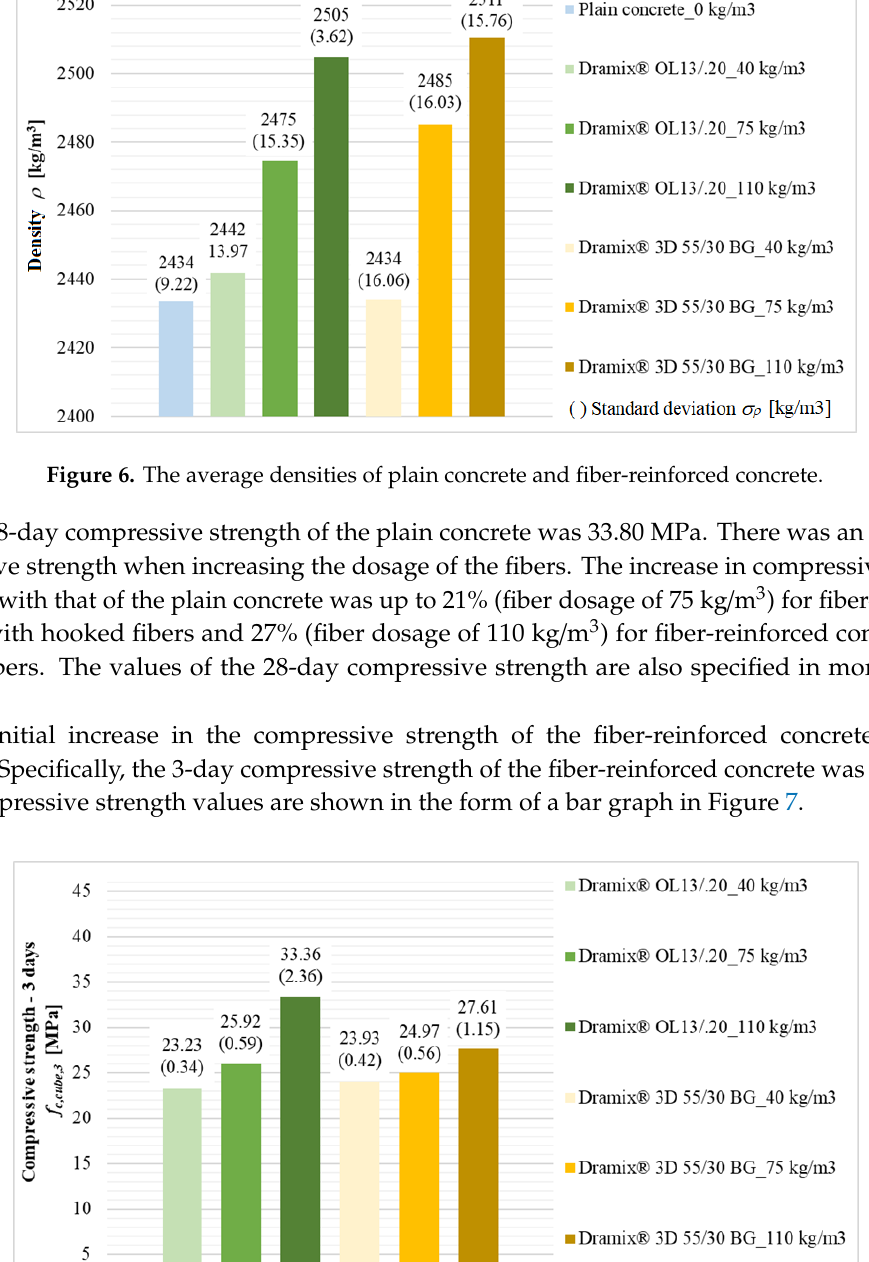
Table 2. Material properties of plain concrete and fiber-reinforced concrete: compressive strength.